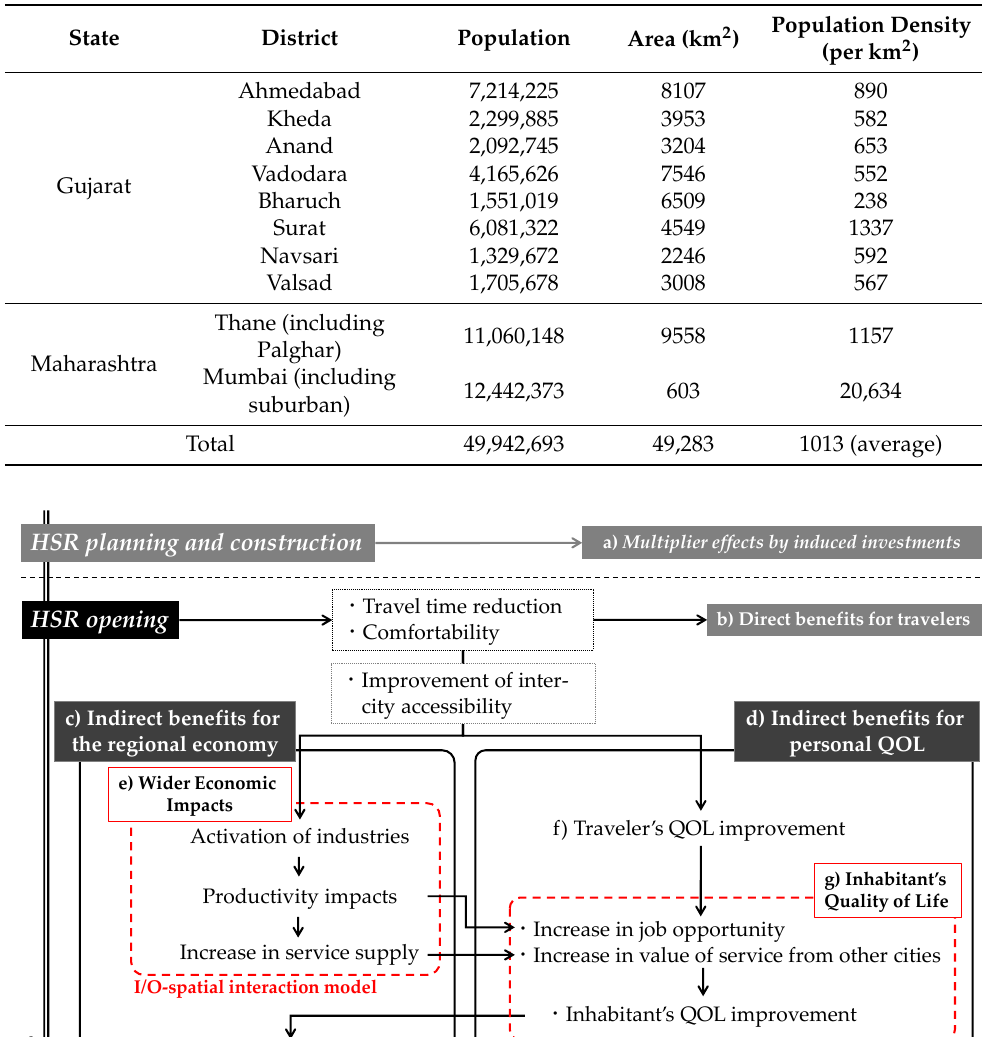
Table 1. Overview of the districts along the MAHSR corridor [4].